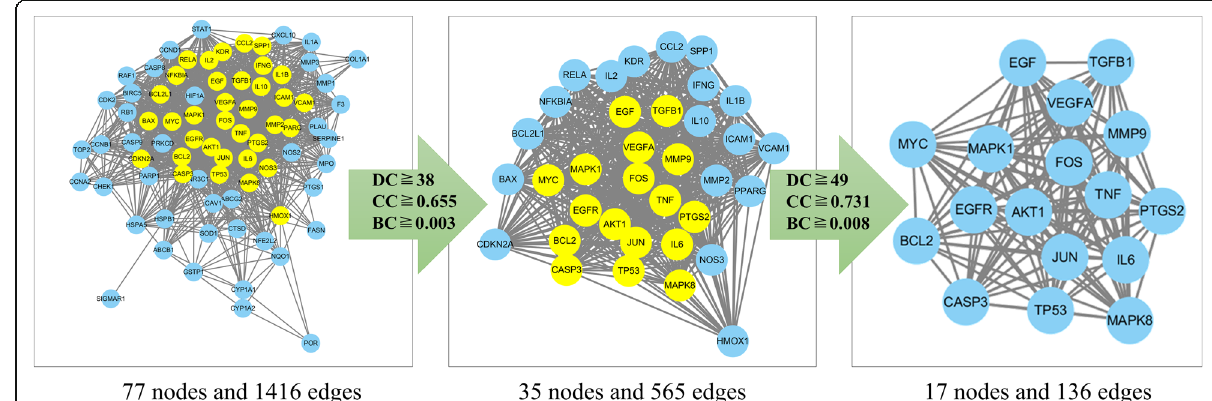
Fig. 4 The process of topological screening for the PPI network